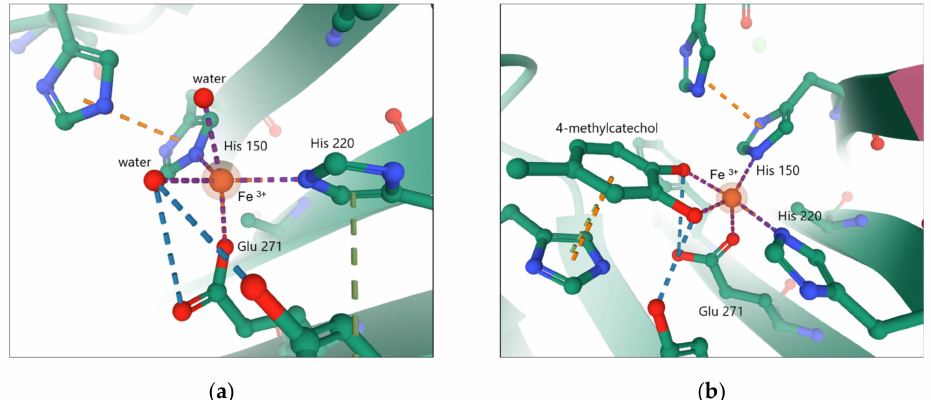
Figure 4. The active center of 2,3-CD with two coordinated water molecules [PDB code 5ZSZ] ( a ) as compared to the active 2,3-CD site that coordinates the 4-methycatechol molecule [PDB code 5ZNH] ( b ).